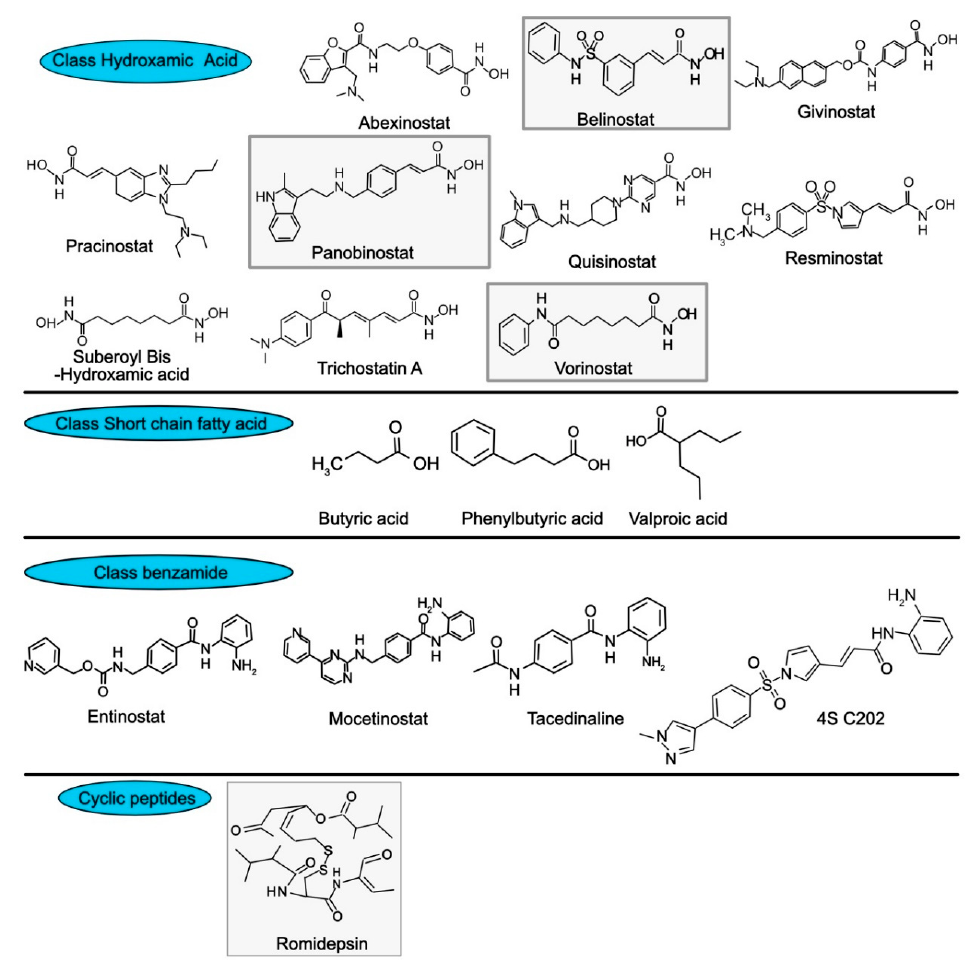
Figure 7. Structure of selected HDAC inhibitors. FDA approved inhibitors are highlighted in the grey boxes.